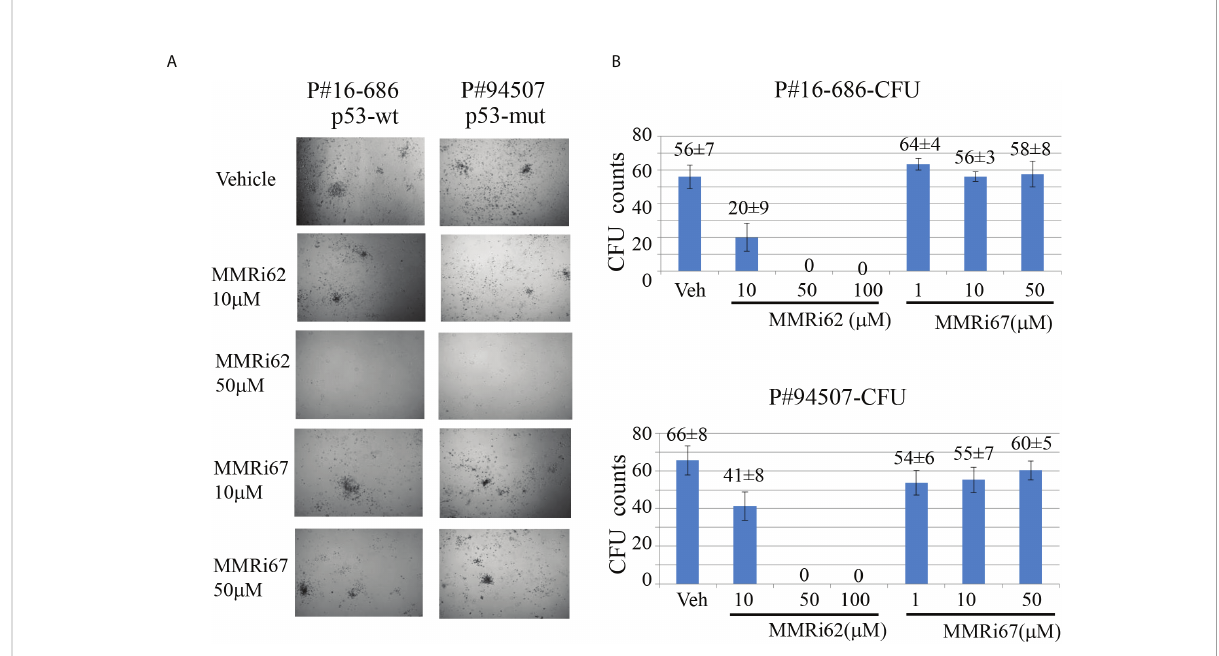
FIGURE 6 MMRi62 induced p53-independent apoptosis and inhibited colony-forming unit (CFU) formation in primary acute myeloid leukemia (AML) patient samples in vitro . (A) Representative images of CFU plates taken after 13 days of culture with primary AML patient samples pre-treated with the indicated concentrations of MMRi62 or MMRi67 for 4 h in a 37°C – 5% CO 2 incubator followed by culturing them in fully supplemented CFU growth media. (B) Quantitative graph of CFU numbers for two AML patient samples treated with either MMRi62 or MMRi67 at different